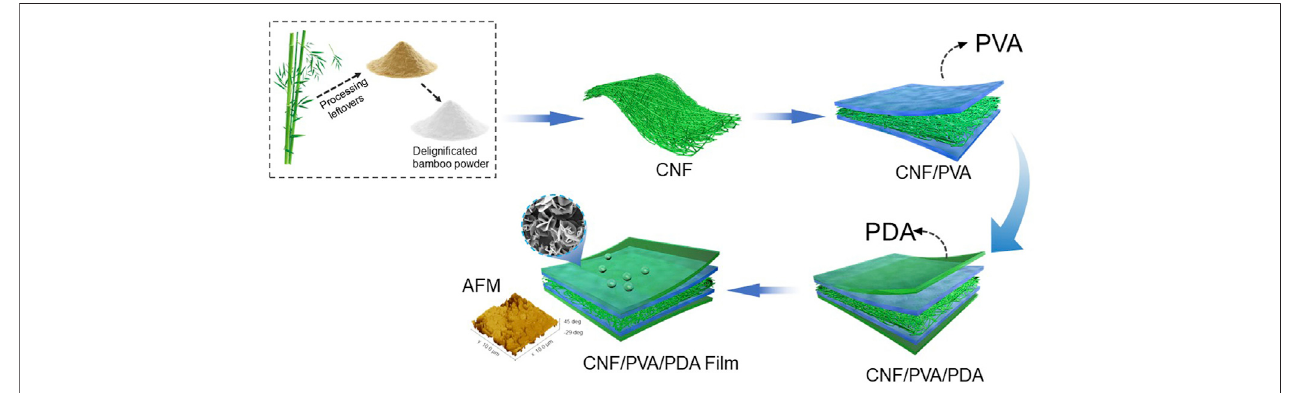
FIGURE 1 | Diagram of the CNF/PVA/PDA preparation process.